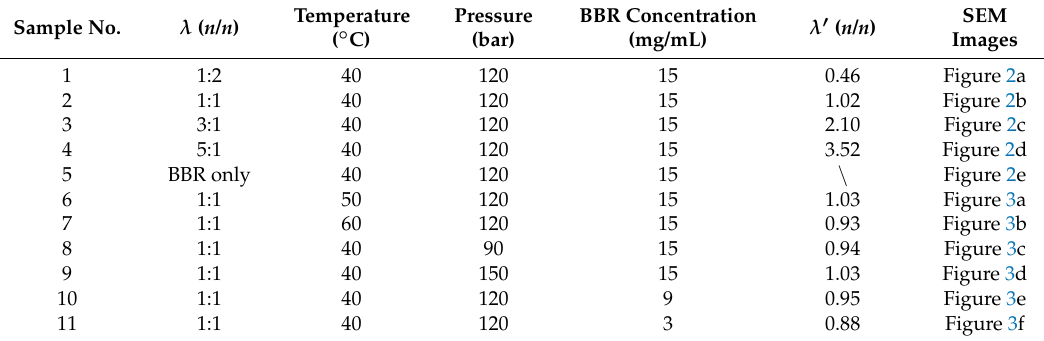
Figure 3. SEM images of a BP prepared under different conditions (temperature, concentration, pressure): ( a ) 50 ◦ C, 120 bar, 15 mg/mL, Sample 6; ( b ) 60 ◦ C, 120 bar, 15 mg/mL, Sample 7; ( c ) 40 ◦ C, 90 bar, 15 mg/mL, Sample 8; ( d ) 40 ◦ C, 150 bar, 15 mg/mL, Sample 9; ( e ) 40 ◦ C, 120 bar, 9 mg/mL, Sample 10; ( f ) 40 ◦ C, 120 bar, 3 mg/mL, Sample 11. Table 1. Operating parameters and BBR contents of a BP prepared via